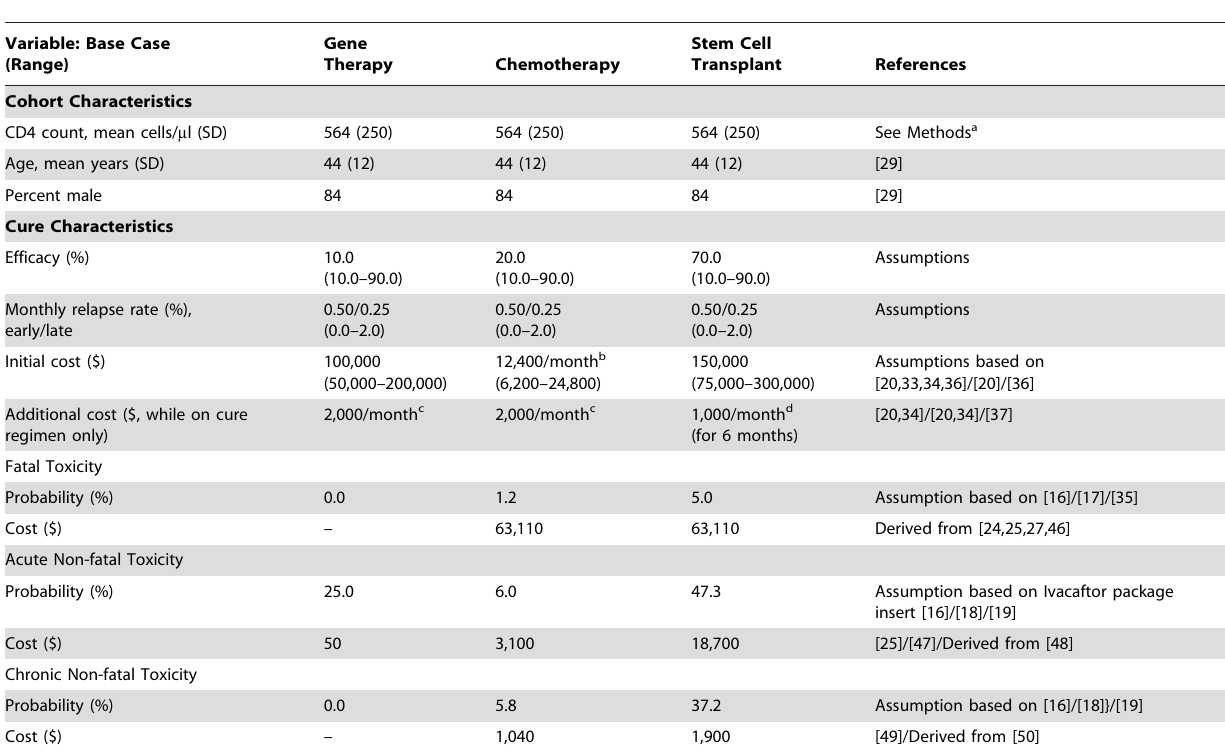
Table 1. Parameter inputs for a model-based analysis of potential HIV cure strategies.